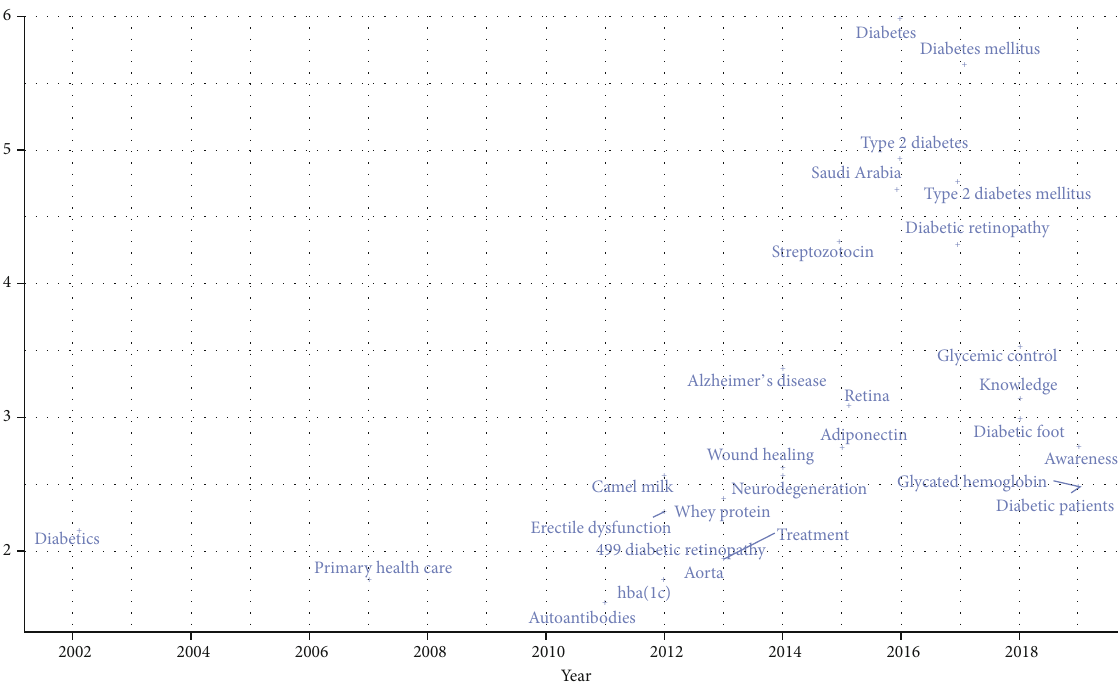
Figure 6: Trend of keywords by